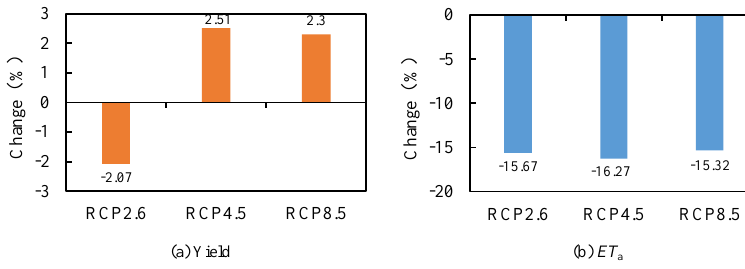
Figure 5. Changes of corn yield and ET a in the Ganzhou area under RCP